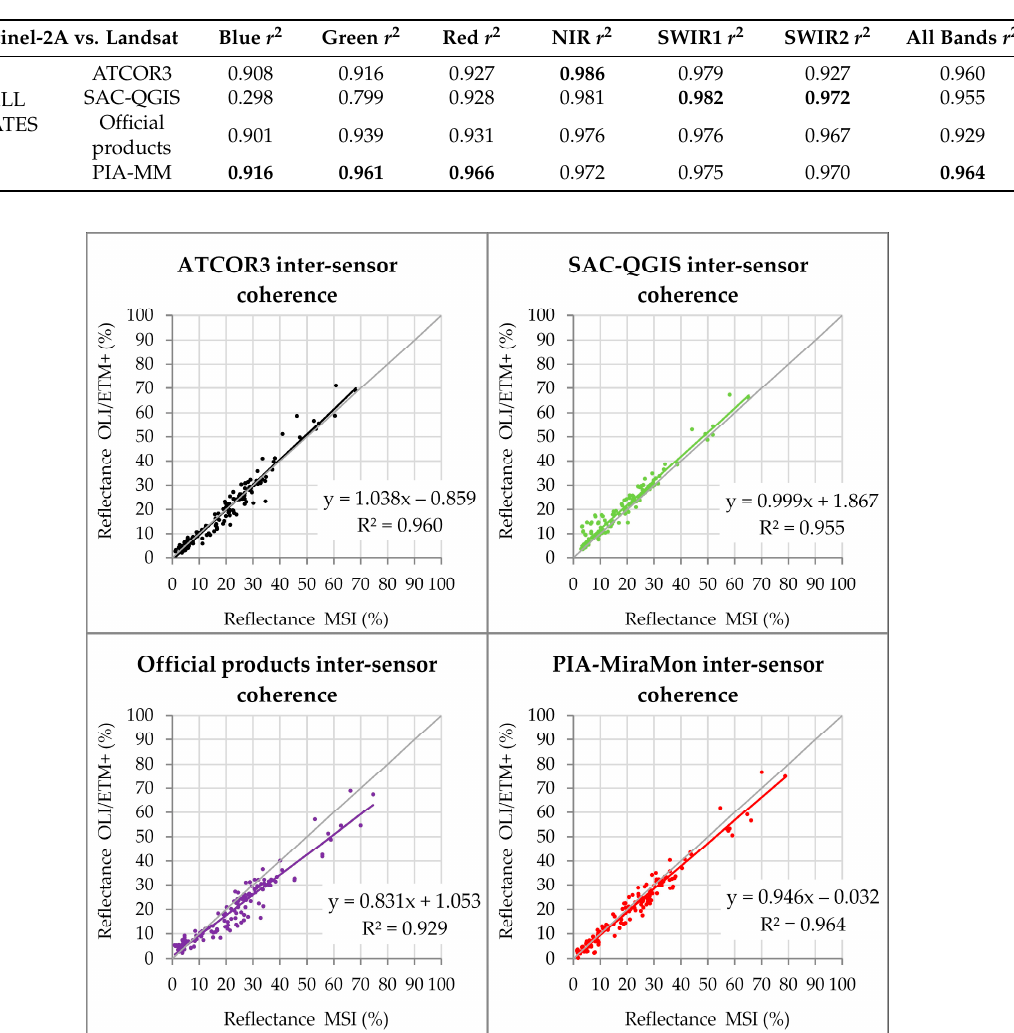
Figure 12. Correlation of Landsat and Sentinel-2A images corrected with the same method (except for official products) evaluating the pixels sampled with field measurements ( n = 156).